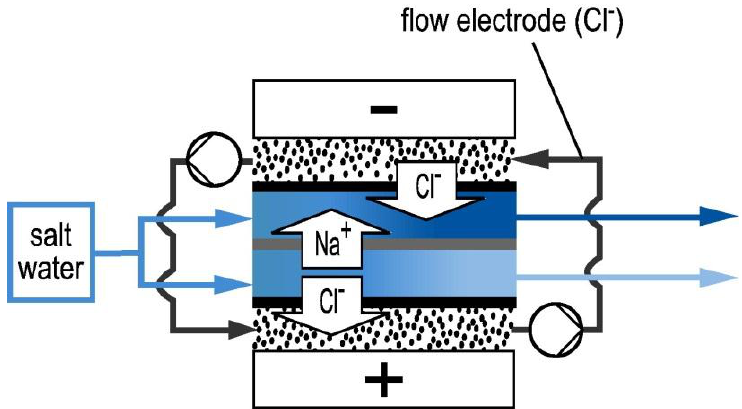
Figure 9. Schematic diagram of Flow-electrode capacitive deionisation (FCDI). Reproduced with permission from Gendel et al. [126], copyright Elsvier, 2014.